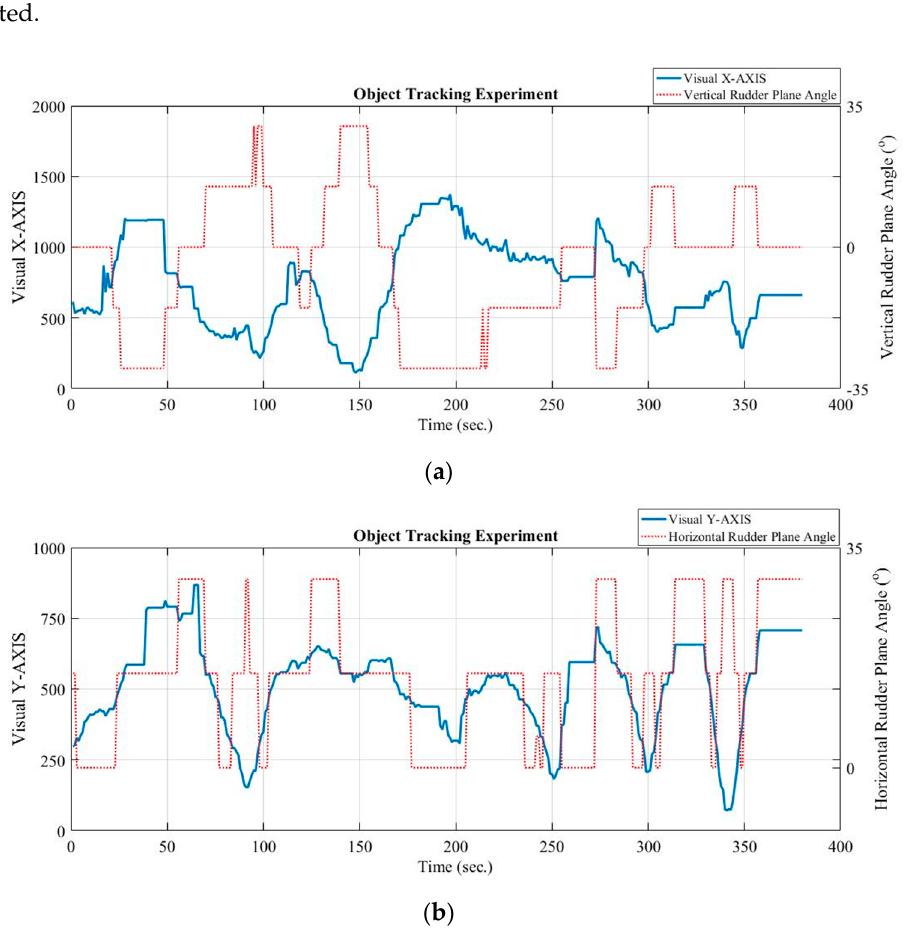
Figure 16. Time series of ( a ) visual x-axis against horizontal rudder angle and ( b ) visual y-axis against the vertical rudder angle.